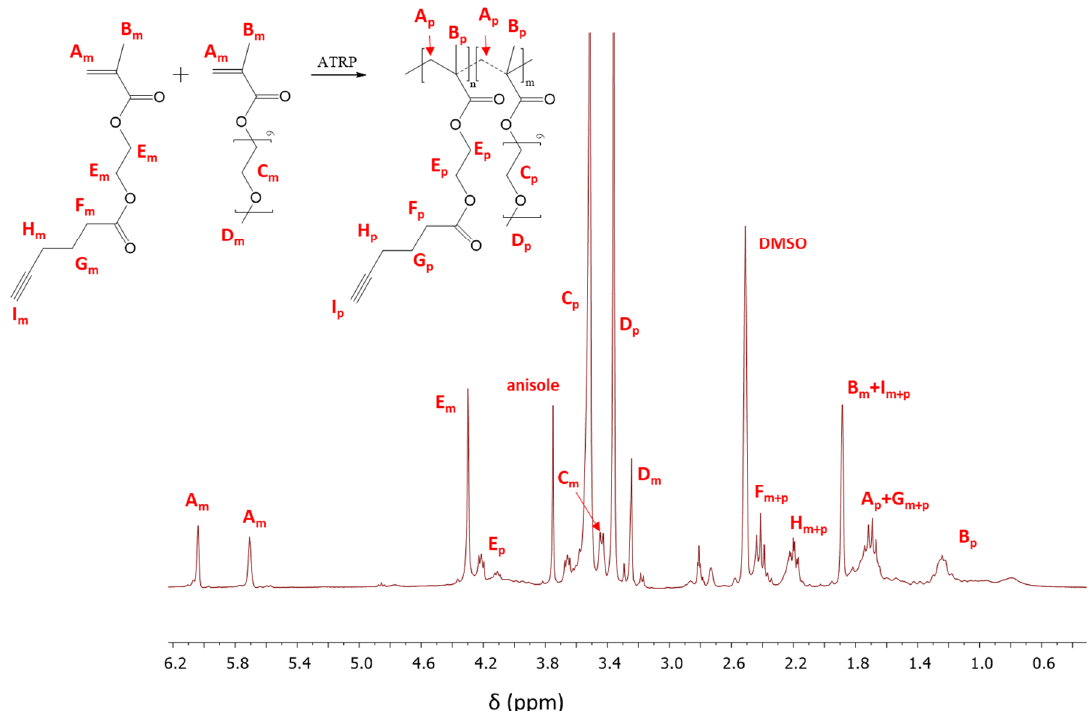
Figure 2. 1 H Nuclear Magnetic Resonance (NMR) spectrum of the reaction mixture for copolymerization of 2-hydroxyethyl methacrylate (AlHEMA) / amphiphilic graft copolymers of poly(ethylene glycol) methyl ether methacrylate (MPEGMA): 75 / 25 (II), m and p indicate the resonances that are related to monomer and polymer, respectively.